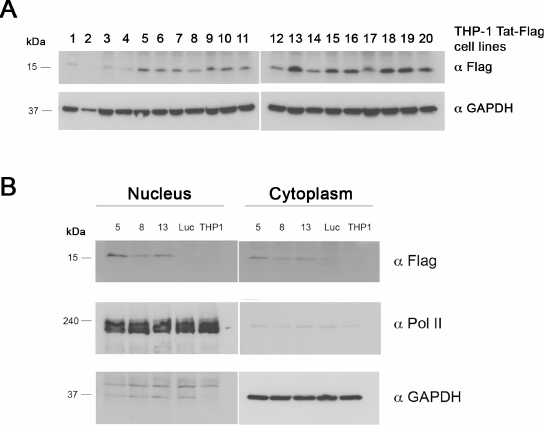
Fig 1. Generation of stable THP-1 cell lines that expressTat-Flag or Luciferase. We infected THP-1 cells with a lentivirusto generatestable cells that express Tat-Flag or luciferase. (A) THP-1 cells infected with Tat- Flag lentivirus and selectedwith puromycin(1.5 ug/ml) for 6 days. The cells were diluted to obtain stable cell lines. Protein lysates were analyzedby western blotting using anti-flag and anti-GAPDH antibodies. (B) THP- 1-Tat-Flag and THP-1- luciferase cell lines were inducedto differentiate into macrophages by treatment with PMA (30 ng/ml) for 24 hours. THP-1-Tat-Flag (cells lines 5, 8, and 13) and THP-1-Luciferase(Luc) as wellas uninfected THP-1 cell wereevaluatedfor nuclearand cytoplasmic expression of Tat-Flag after cell fractionation by Western blotingusinganti-Flag, anti-PolII (nuclear expression) and anti-GAPDH(cytoplasmicexpression) antibodies. Almost all stable cells expressedTat-Flag, and it was localizedin the nucleusandcytoplasm.We obtainedthe same results with 4–5independentsets of infectionsand selectionof THP-1-Tat-Flag and THP- 1-Luciferase cell